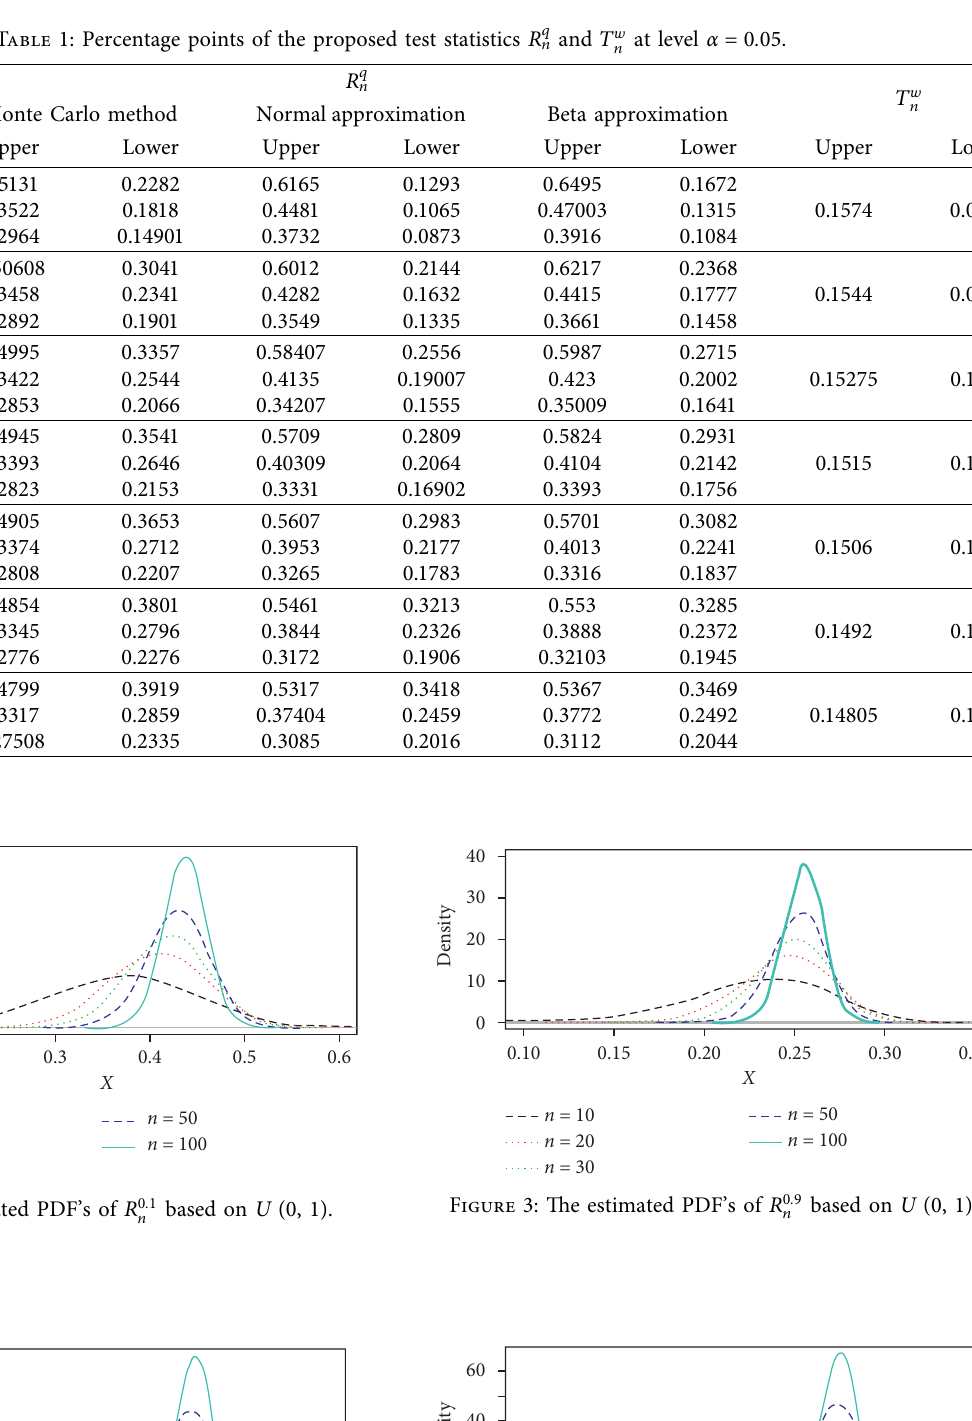
n based on U (0, 1).